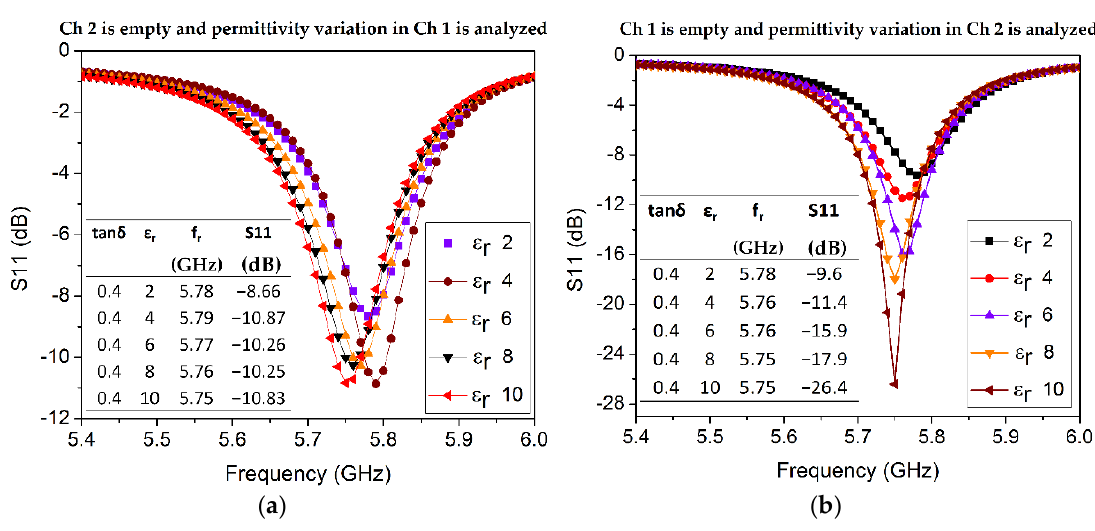
Figure 9. Effect of permittivity variation of material inside the channel on the sensitivity of the proposed sensor. ( a ) Ch 2 is empty, and permittivity variation in Ch 1 is analyzed. ( b ) Ch 1 is empty, and permittivity variation in Ch 2 is analyzed. Loss tangent value is considered as a constant (tan δ = 0.4) during these sets of simulations.